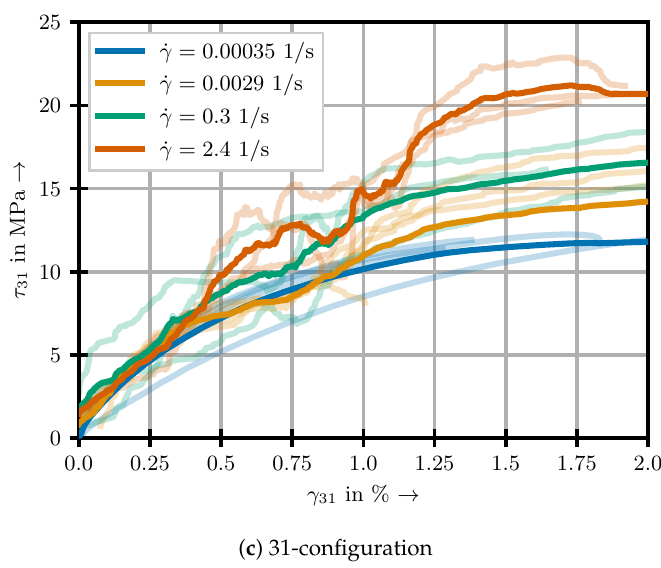
Figure 3. Stress–strain curves for the investigated material configurations.